Question: From the figure, is the trend upward or downward?
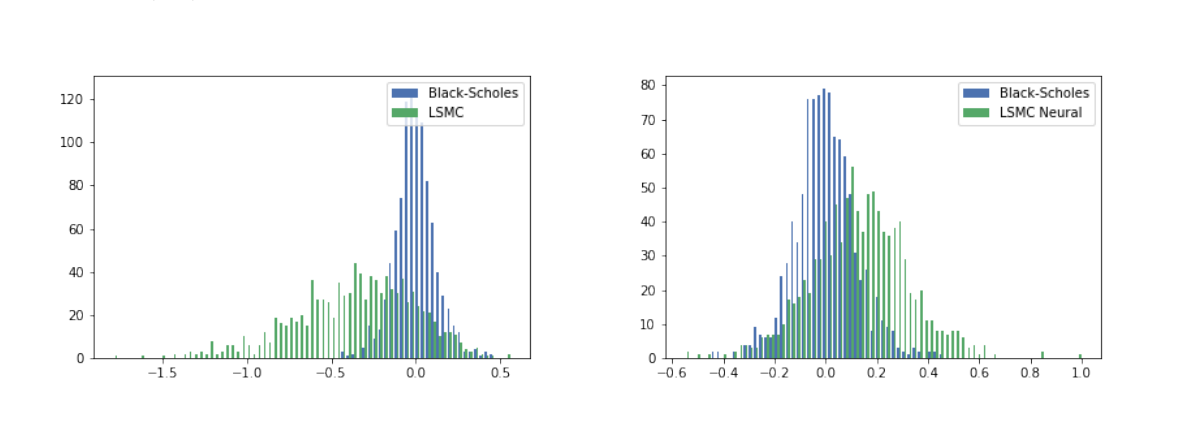
Answer: increasing